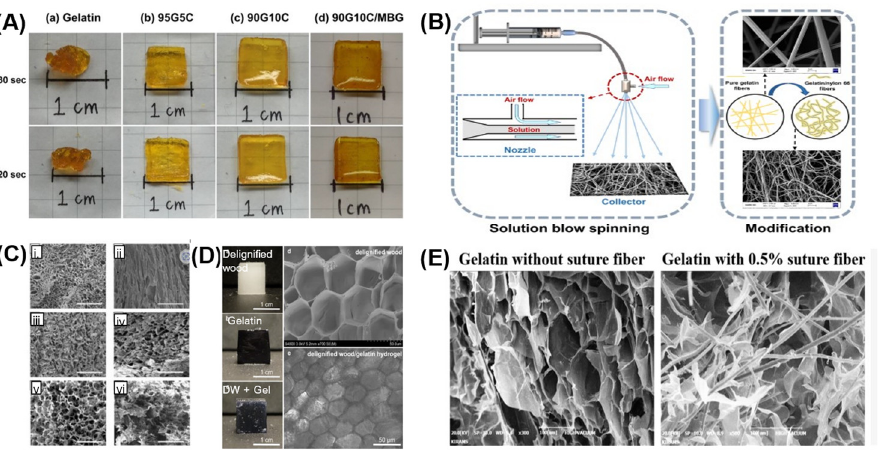
Figure 6. Fiber-reinforced gelatin enhancements. ( A ) Various sealant gelatin-collagen fibril compositions containing 20% mesoporous bioactive glass exposed to an LED light for different durations [99]. ( B ) Fabricating gelatin-nylon 66 nanofibers through solution blow spinning with improved mechanical properties [100]. ( C ) Cross- and sagittal-sectioned SEM images of ( i , ii ) gelatin; ( iii , iv ) CNFs; ( v , vi ) (Gel:CNFs)-75:25 [101]. ( D ) Delignified wood fiber reinforcement, gelatin, and delignified wood/gelatin hydrogel. SEM image of freeze-dried delignified wood with a well-preserved cellular structure, and optical microscopy image of a delignified wood/gelatin composite hydrogel [102]. ( E ) The SEM images of a gelatin biomaterial ink without suture fibers and with suture fibers [103]. (Images ( A – E ) are licensed under CC BY 4.0 (http://creativecommons.org/licenses/by/4.0/ (accessed on 30 October 2022))).